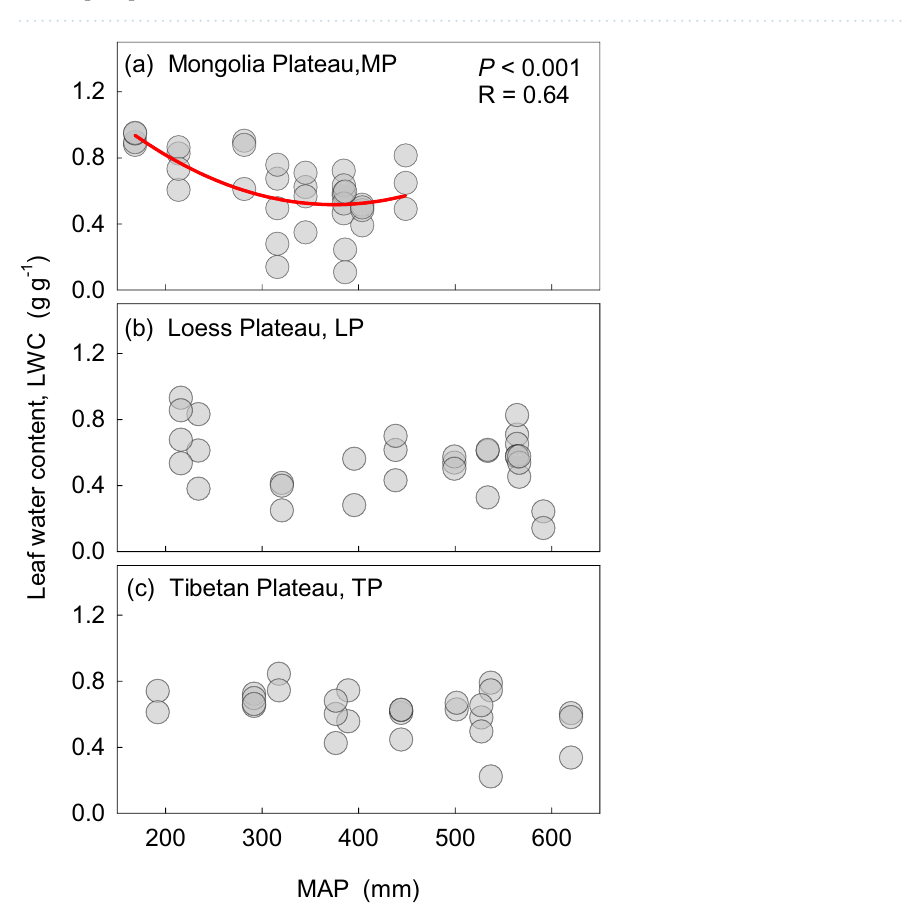
Figure 4. Relationship between leaf water content (LWC) and mean annual precipitation (MAP). Panels ( a ), ( b ) and ( c ) show the LWC correlated with MAP on the Mongolia Plateau (MP), Loess Plateau (LP), and Tibetan Plateau (TP). Figures were done by SigmaPlot version